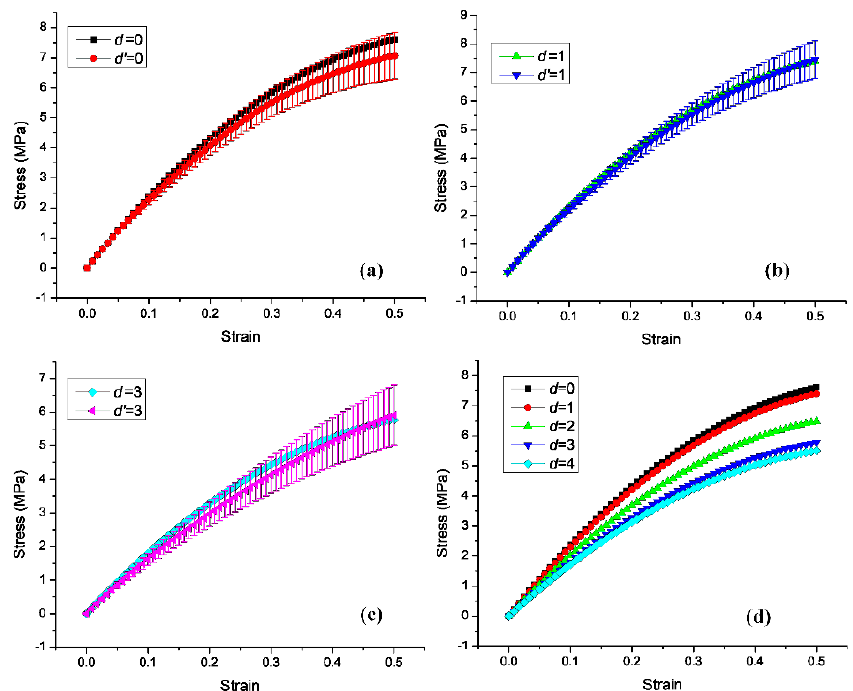
Figure 4. Stress–strain curves of the Abaqus simulation and tensile tests, where d represents the simulation results and d ′ represents the experimental results: ( a ) d = d ′ = 0, ( b ) d = d ′ = 1 mm, and ( c ) d = d ′ = 3 mm. ( d ) Stress–strain curves of the five structures ( d = 0, 1, 2, 3, and 4 mm) simulated in Abaqus.